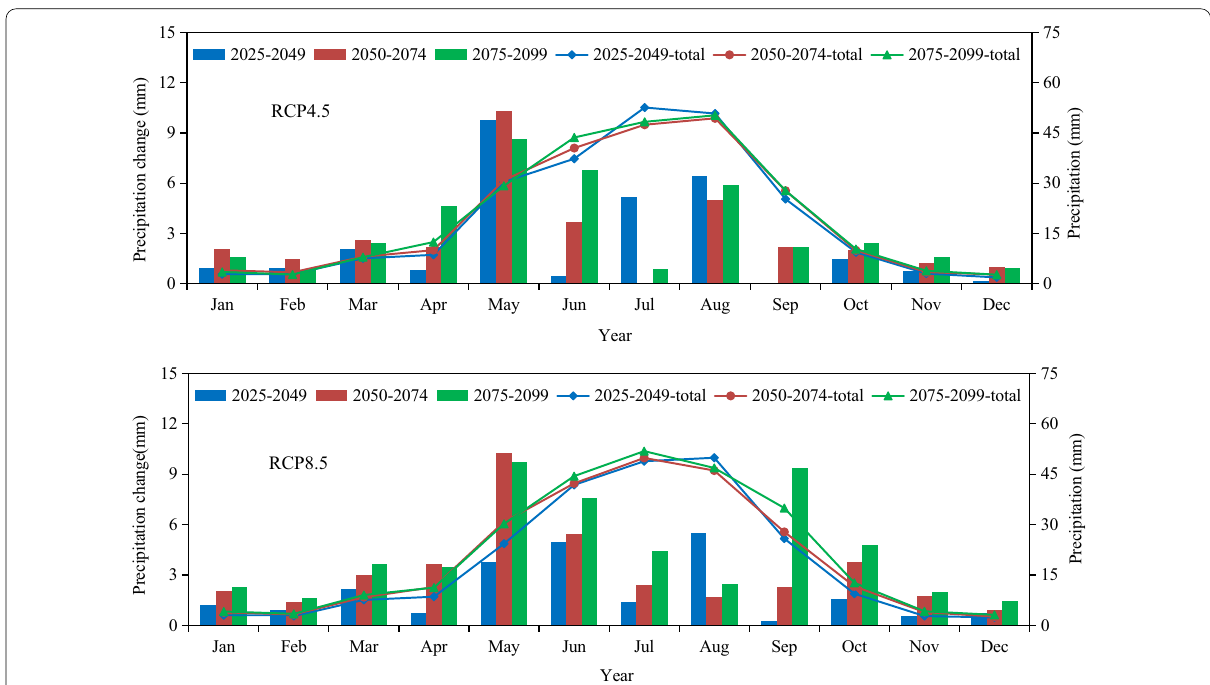
Fig. 5 Precipitation change of future precipitation data under RCP4.5 and RCP8.5 scenarios with respect to the historical period